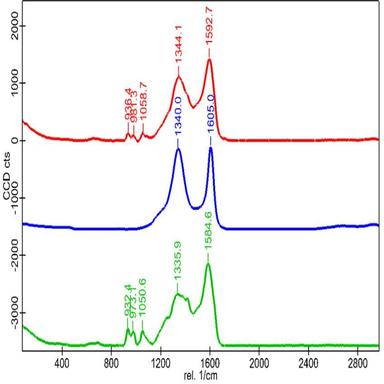
Raman spectrum of Janus Ppy-GAC nanocomposites (red), AC (blue) and Ppy Nanoparticles (green).